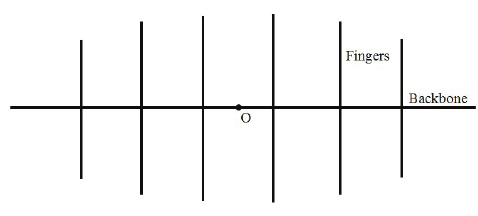
Figure 2. The schematic of a comb